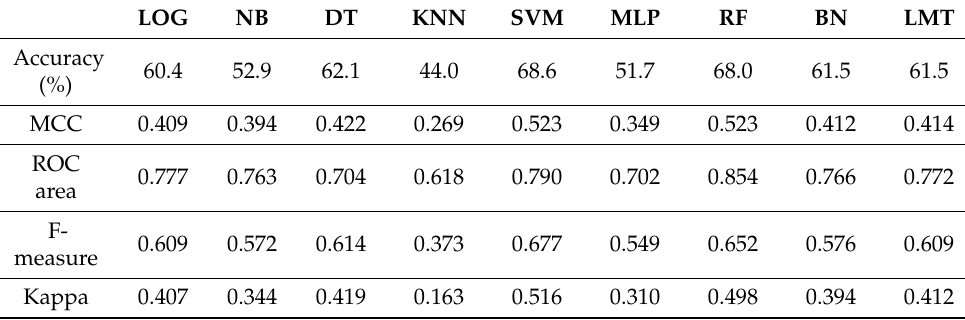
Table 5. Classifiers’ evaluation metrics.